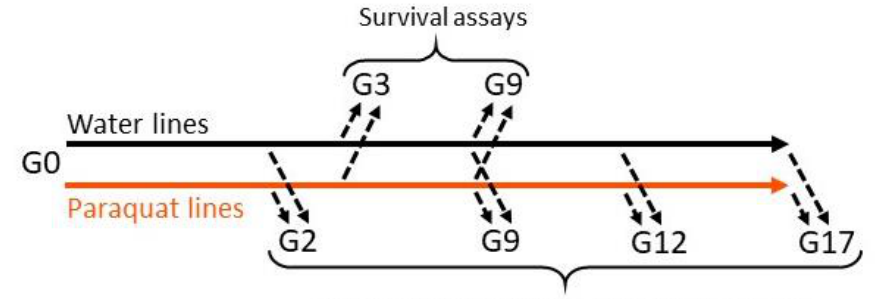
Figure 1. Summary diagram of the experimental evolution experiment, showing the generations (G0- G17) at which the different measurements were